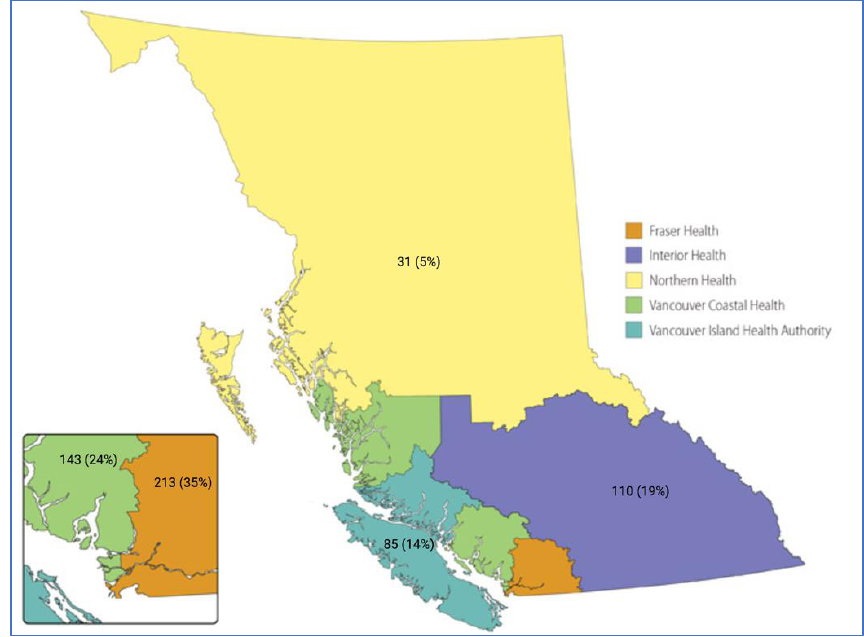
Figure 1. Depicted is a rendering of the province of British Columbia (www2.gov.bc.ca, accessed on 17 December 2022). Each BC provincial health authority is color labeled as indicated in the legend, and n (%) for each respective health authority depicts the proportion of late stage NSCLC patients who underwent molecular profiling at the BC Cancer Genomic Lab during the study period (May 2020 to June 2021). The 11 (1.9%) out of province records are not depicted.